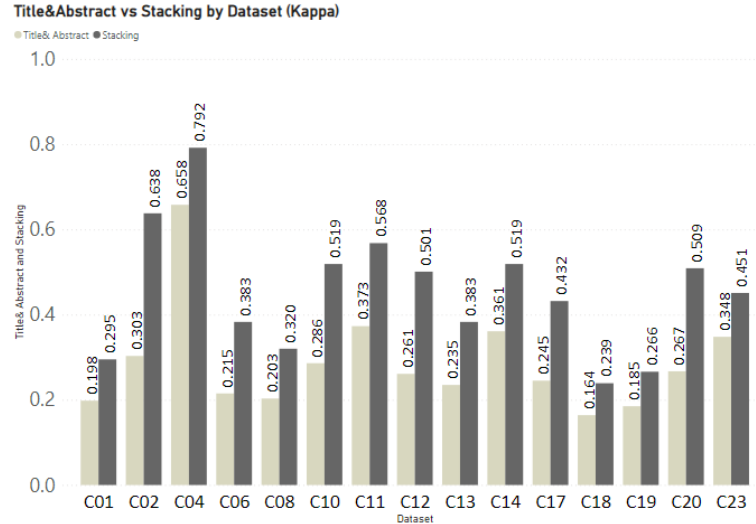
Figure 5. Kappa values of the datasets where stacking is the best statistically tested technique.